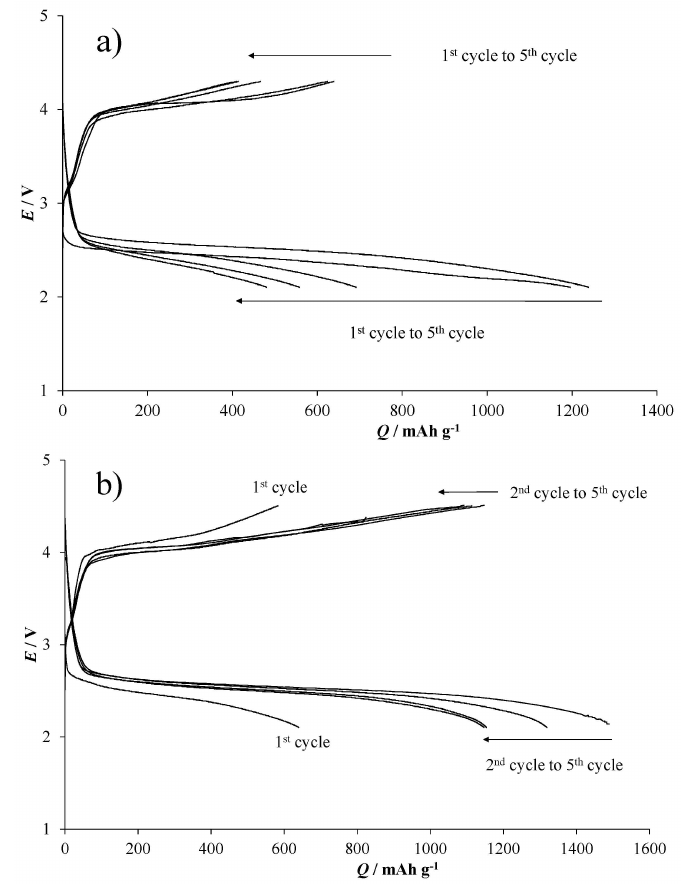
Figure 7. Discharge and charge cycles for ( a ) GDE-H-M_hydro and ( b ) GDE-H-M_hydro_1.0%Ag in the H